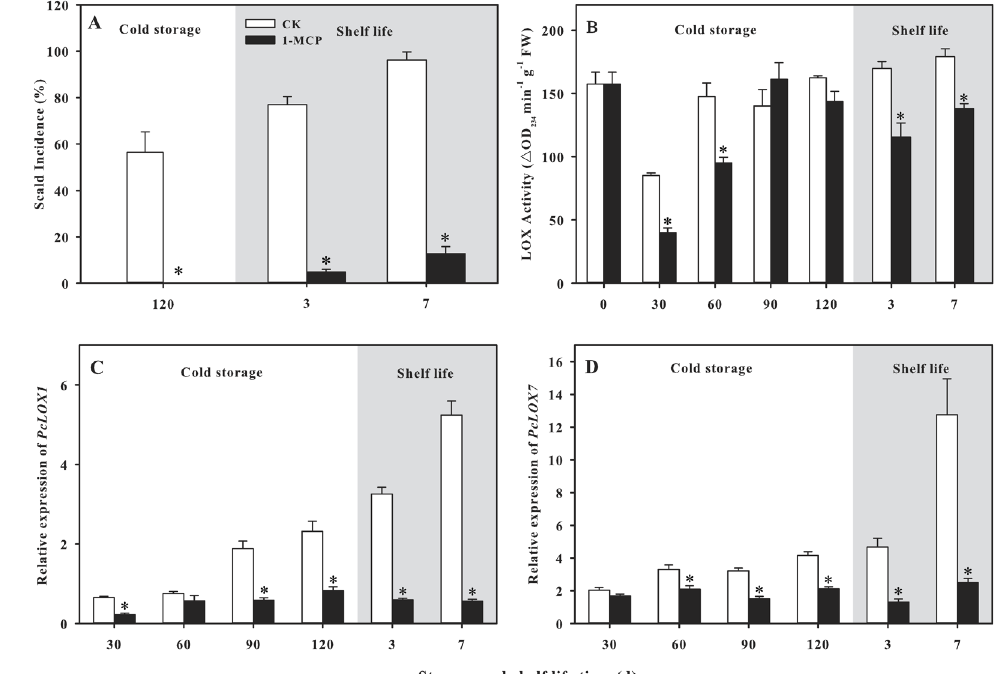
Fig. 4: LOX activity and gene expression in fruit peel during scald development during cold storage and shelf life. (A) Superficial scald incidence; (B) LOX activity; (C) and (D) expression of PcLOX1 and PcLOX7 genes. Data are the means ± SE of three replicates. The vertical bars represent the standard errors of the means. The ‘*’ represents a significant difference ( P < 0.05), and the “**” represents a very significant difference ( P <